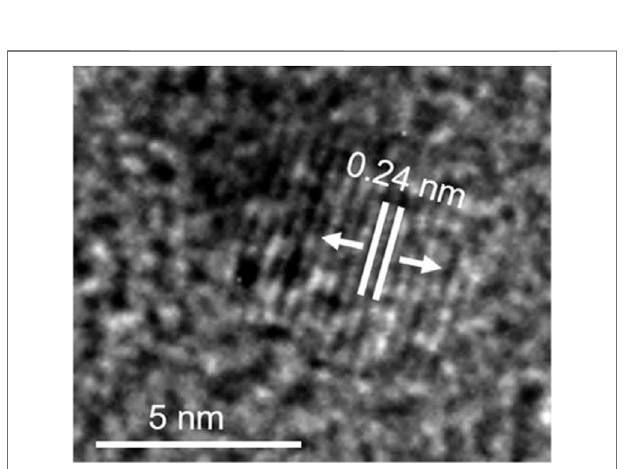
FIGURE 3 | High resolution transmission electron microscopic (H-TEM) image of a single CQD showing graphitic spacing. (Reproduced from Das et al., 2019, Springer